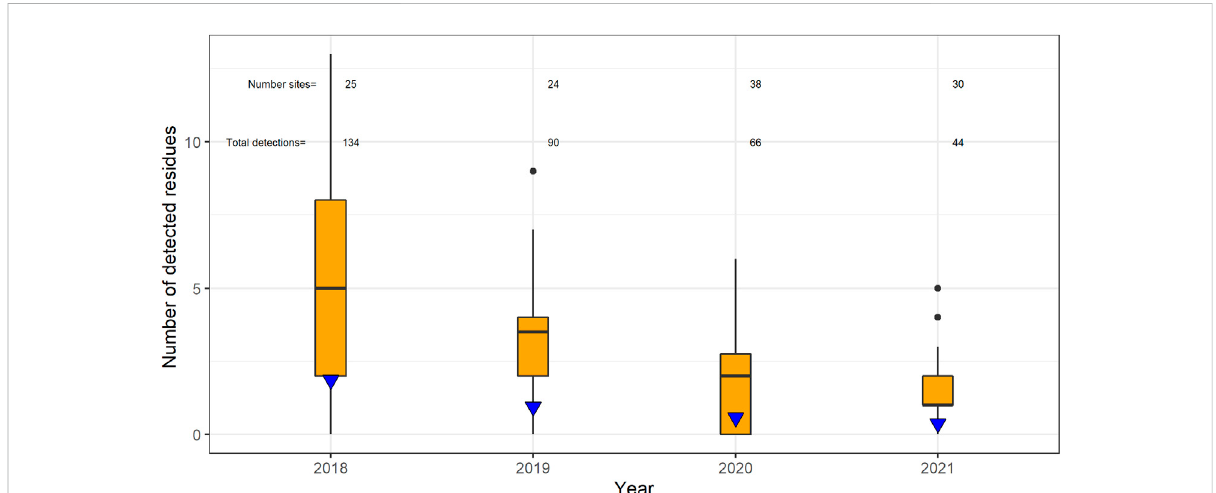
FIGURE 5 Number of detected residuesper year. The boxes are based on the annual sum ofresiduesfor every site. The bluetriangle represents the mean number of detections per sampling. The upper number gives the number of monitored playgrounds per year ( “ Number sites ” ). The lower number gives the number of detected residues per year ( “ Total detection ” ), among all playgrounds. For statistics see Table 3.